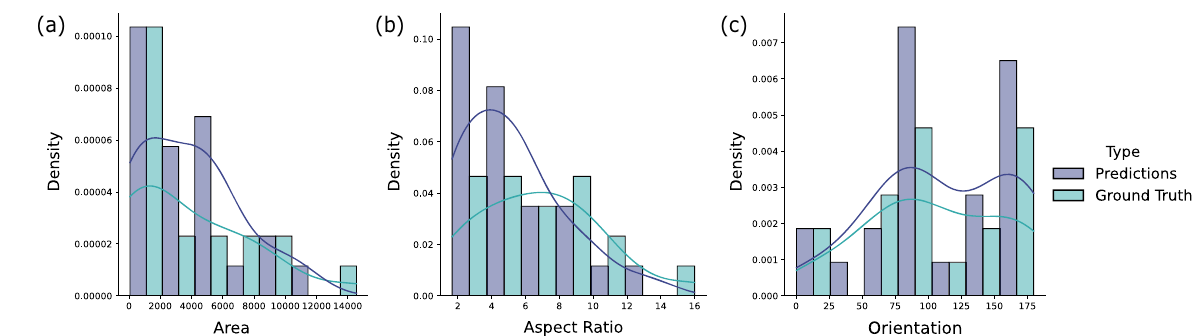
Fig. 5 Particle statistics from the X-ray ptychography image. Histograms and their kernel-density estimates (KDE) are illustrated as a function of area (summation of pixels corresponding to each particle mask), aspect ratio (particle length/width), and orientation (angle relative to the horizontal axis) in a – c , respectively. The statistical results show qualitative agreement; however, the main discrepancy represented by over-predicted pixels cause the shift of KDE curve in the respective number ranges.